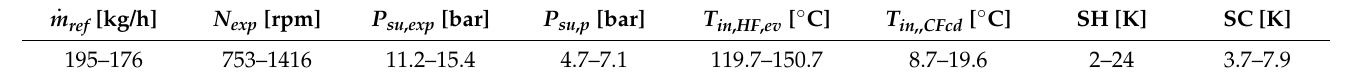
Table 3. Range of working conditions during the experimental tests